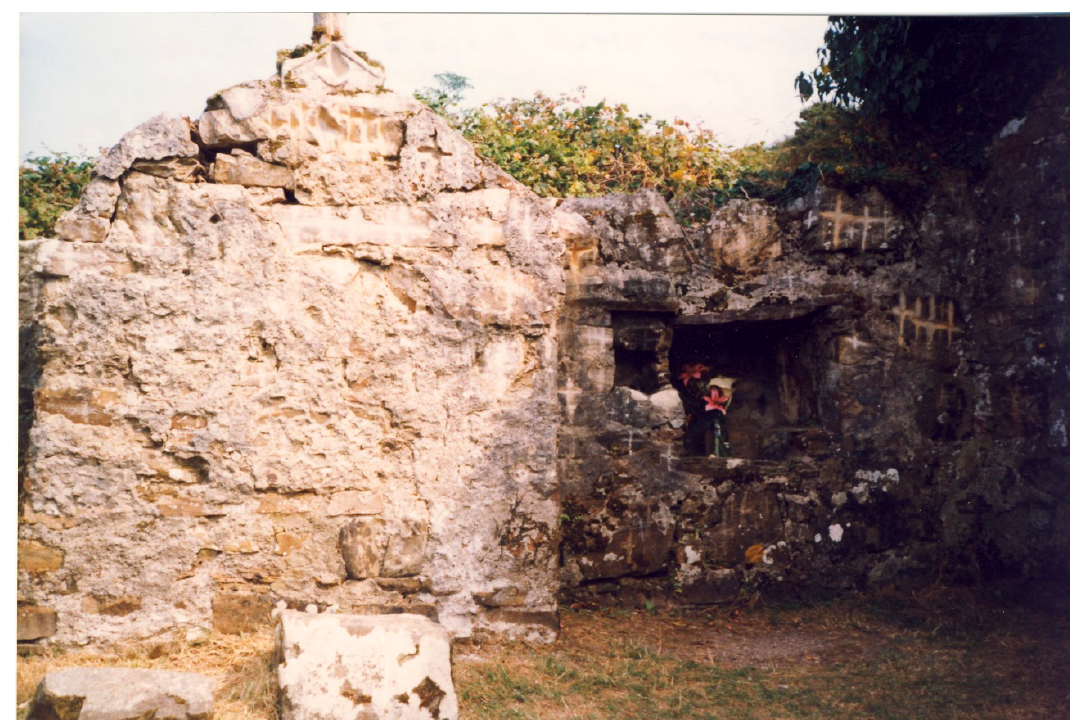
Figure 12. Crosses inscribed in the wall of St. Declan’s Church,